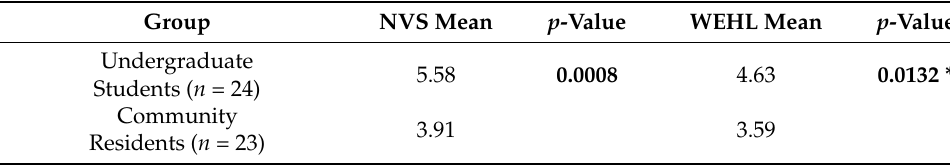
Table 3. Comparison of group NVS and WEHL